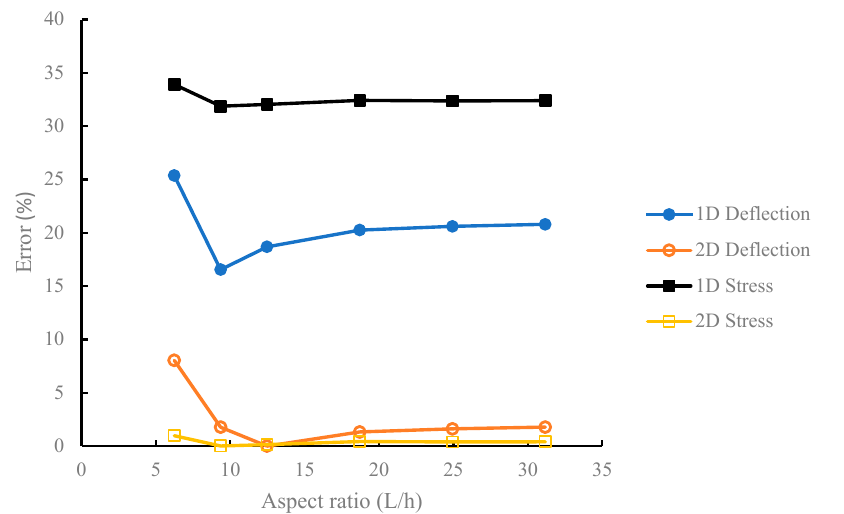
Figure 4. Comparison of deflection and stress errors of 1D and 2D symmetrical laminated narrow flange T-beams at different aspect ratios.